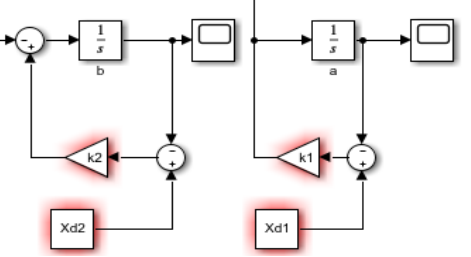
Figure 10. Block diagram for basting process with two state variables.